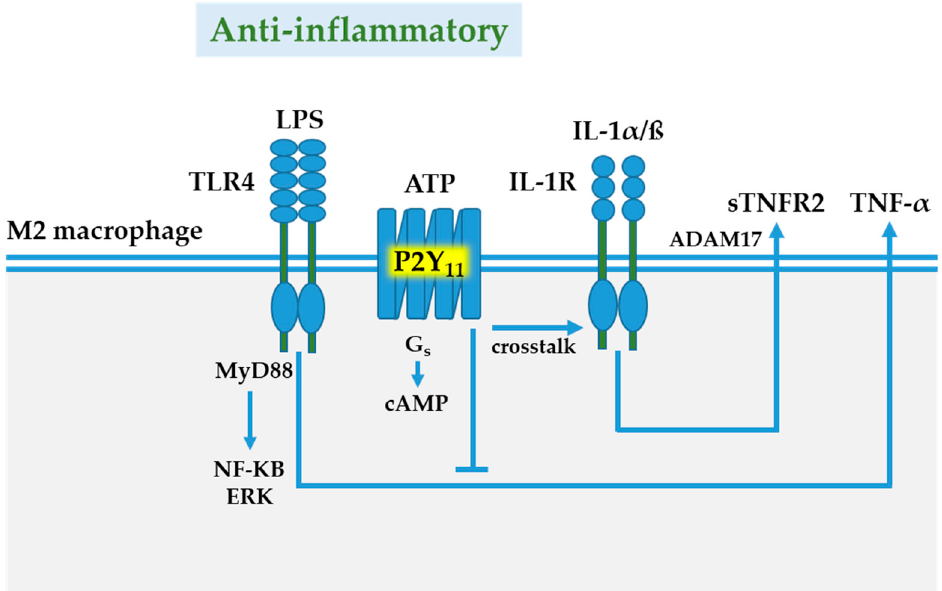
Figure 2. P2Y 11 receptor-mediated anti-inflammatory responses. TLR4/IL-1R signaling via MyD88/NF-KB/ERK is a major pathway of macrophage activation. In anti-inflammatory M2